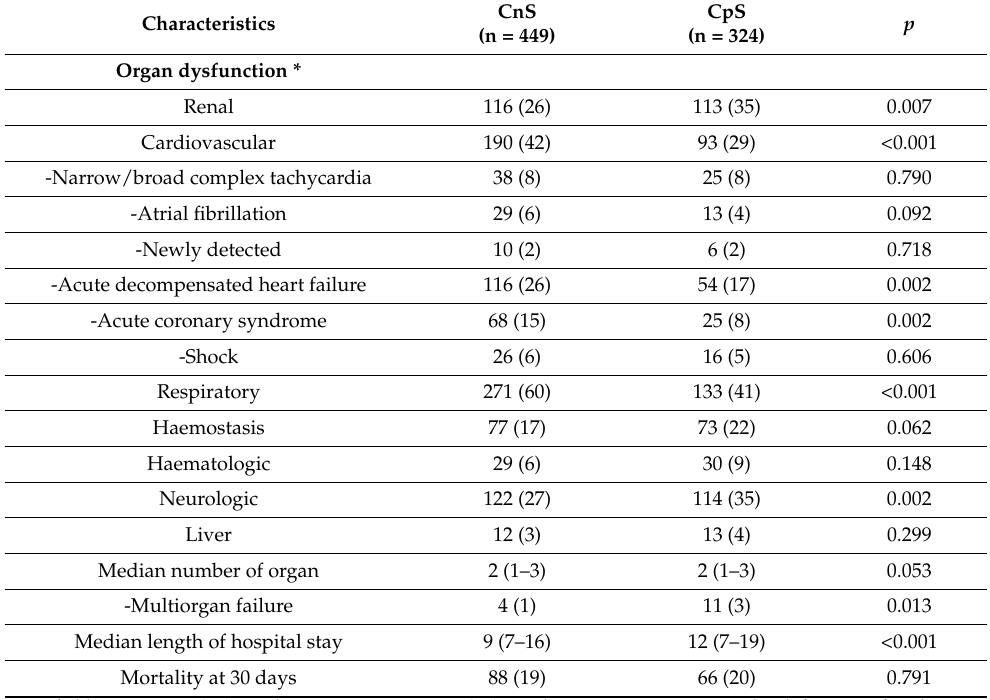
Table 2. Outcome at 30 days.